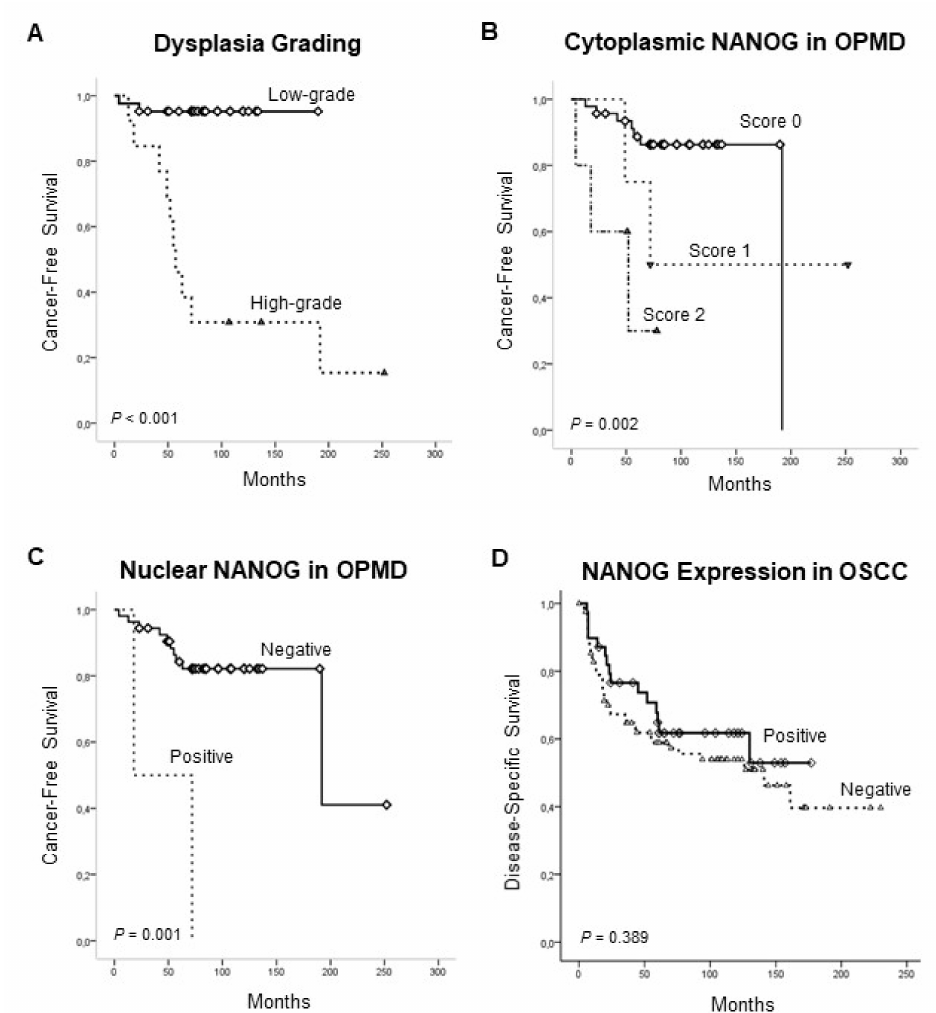
Figure 2. Kaplan–Meier cancer-free survival curves in the cohort of 55 patients with oral epithelial dysplasia categorized by histological grading (low-grade vs. high-grade) ( A ), cytoplasmic NANOG (Staining scores 0, 1 and 2) ( B ) and nuclear NANOG expression (positive vs. negative) ( C ). Disease-specific survival curves in the cohort of 125 OSCC patients dichotomized according to NANOG expression (positive vs. negative) ( D ). Table 4. Multivariate Cox proportional hazards model to estimate oral cancer risk. Variable p Hazard Ratio Histology (High-grade vs. low-grade dysplasia) < 0.001